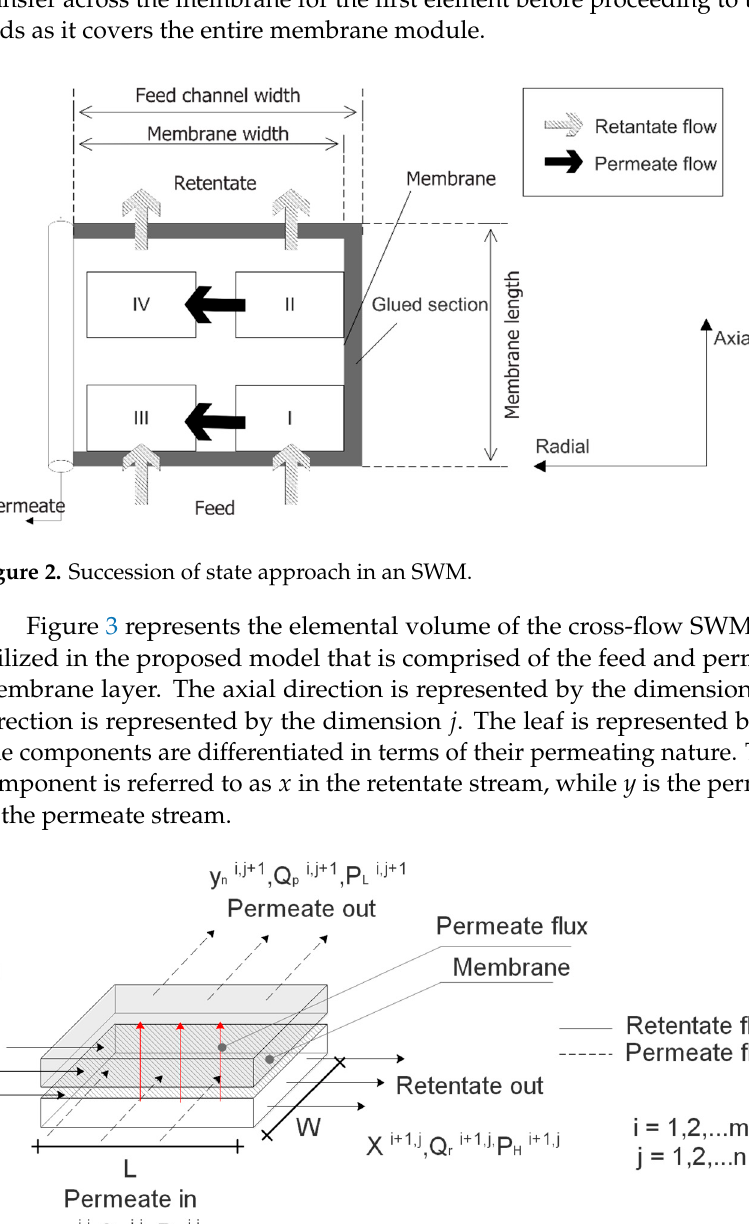
Figure 3. Schematic representation of an elemental volume in the cross-flow SWM element. The characterization of transport across the cross-flow SWM module element using Fick’s law of diffusion, is described in Equation (6):